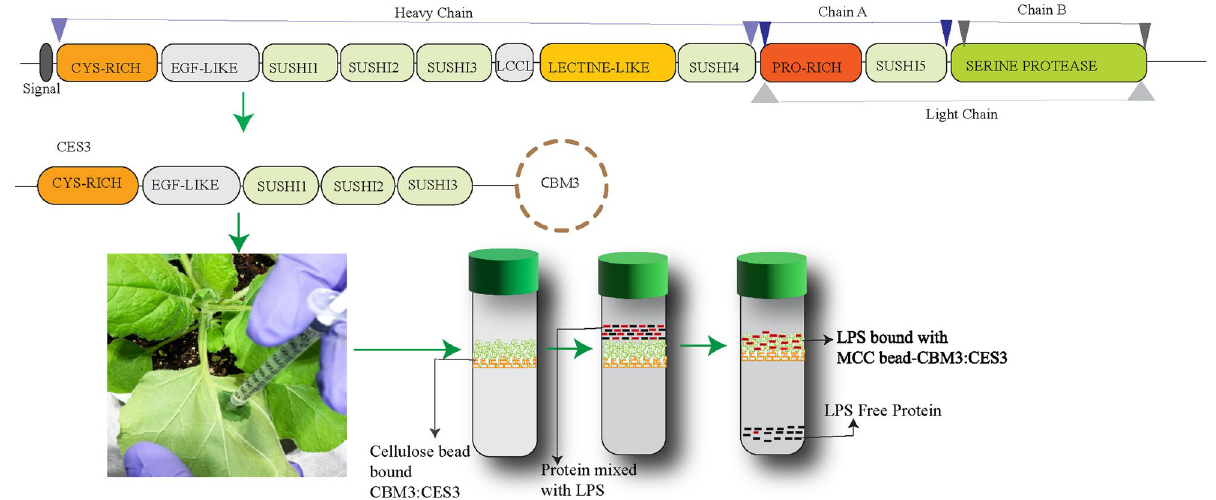
Figure 7. A model of LPS removal from protein samples using CES3:CBM3 immobilised onto MCC beads. Factor C of Limulus amoebocyte lysate (LAL) is composed of different domains, and the N-terminal CES3 is responsible for LPS sensing and shows high affinity binding. We produced a chimeric recombinant protein consisting of CES3 and CBM3, a cellulose-binding domain, in plants and immobilised onto MCC beads. The CES3:CBM3-MCC bead can be used to remove LPS from the protein